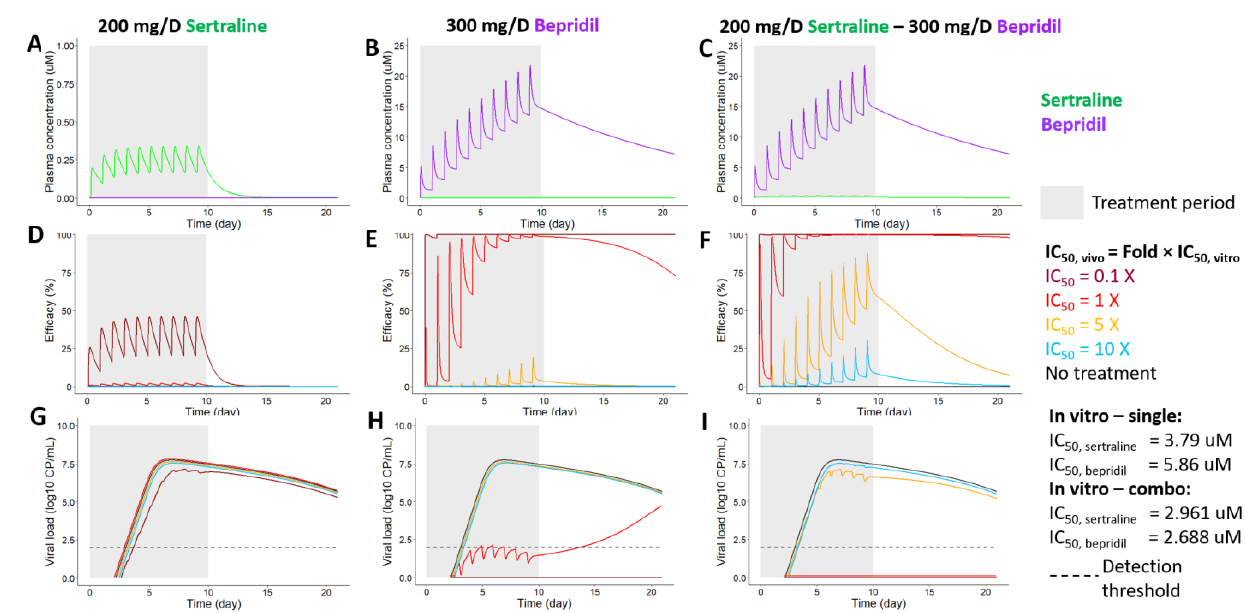
Figure 7. Projections of pharmacokinetics (PK), pharmacodynamics (PD), and EBOV viral load dynamics when sertraline and bepridil are used alone and together. Treatment periods start on day 0 and end on day 10, as indicated with gray backgrounds. Doses are 200 mg/day for the single sertraline treatment ( A , D , G ), 300 mg/day for the single bepridil treatment ( B , E , H ), and 200 mg/day sertraline—300 mg/day bepridil for the treatment of the drug combination ( C , F , I ). We assumed various in vivo IC 50 s in each treatment, which are shown in colors of sky blue for 10 × , orange for 5 × , red for 1 × and dark red for 0.1 × of in vitro IC 50 s (panels D – I ). ( A – C ) PK projections of sertraline (in green) and bepridil (in purple) and their combination. Note: The concentration of sertraline equals 0 µ M over time in the single bepridil therapy ( B ), while it is greater than 0 µ M (~0.25 µ M) during the treatment period (gray shaded region) in the drug combination therapy ( C ). ( D – F ) Projected efficacies of single sertraline, single bepridil, and their combination under assumptions of various in vivo IC 50 s. ( G – I ) Model-simulated EBOV viral load dynamics (log 10 (Cp/mL), log 10 (copy number/mL)) under different treatment regimens: single sertraline, single bepridil and their combination, when in vivo IC 50 s were varied. In graphs G – I , in cases where curves overlap (e.g., for the 5 × and 10 × simulations of in vivo IC 50 s), the lines were shifted just enough to better visualize the predicted viral loads. Note: a straight line at zero (e.g., in panels H , I ) indicates a lack of detectable remaining